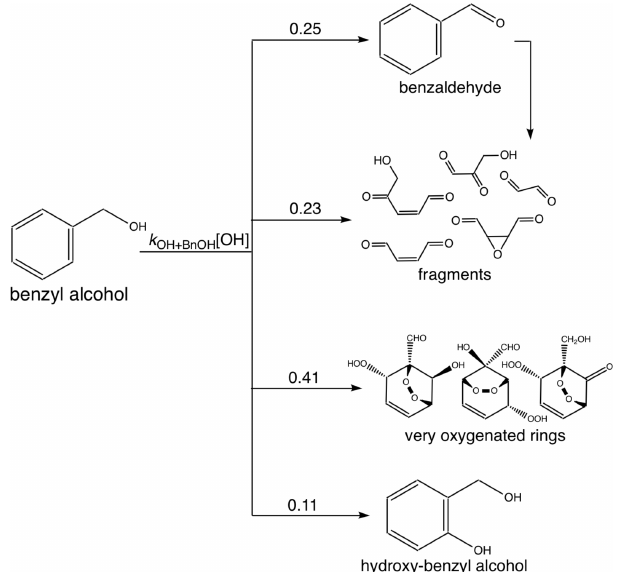
Figure C1. Benzyl alcohol reaction scheme used for simulations, roughly derived from Wang